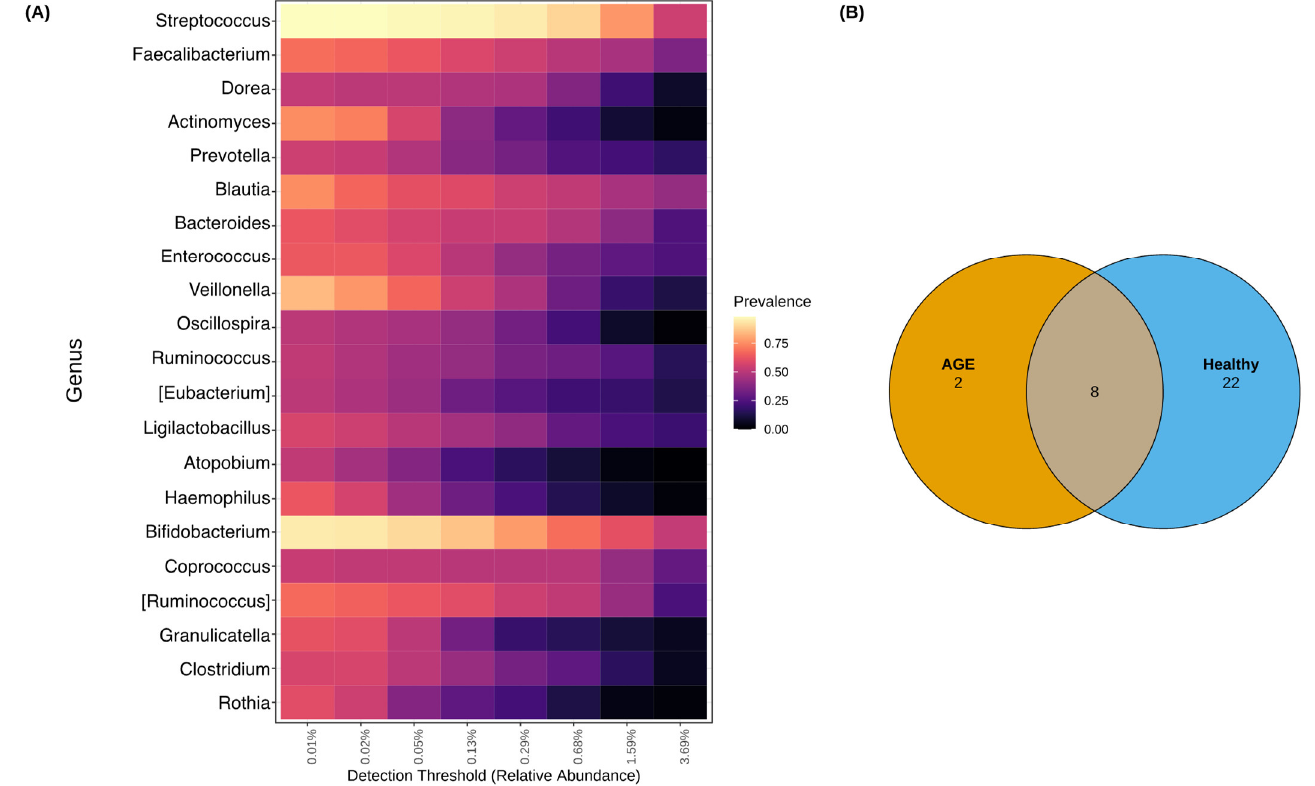
Figure 3. Core genera of AGE cases and healthy controls. ( A ) Heatmap of core genera across samples of the two groups. Genus names are shown. ( B ) Venn diagram of the number of core genera identified within AGE cases and healthy controls. Core genera were identified using a 50% prevalence cut-off and an abundance cut-off of 0.01% (0.0001).